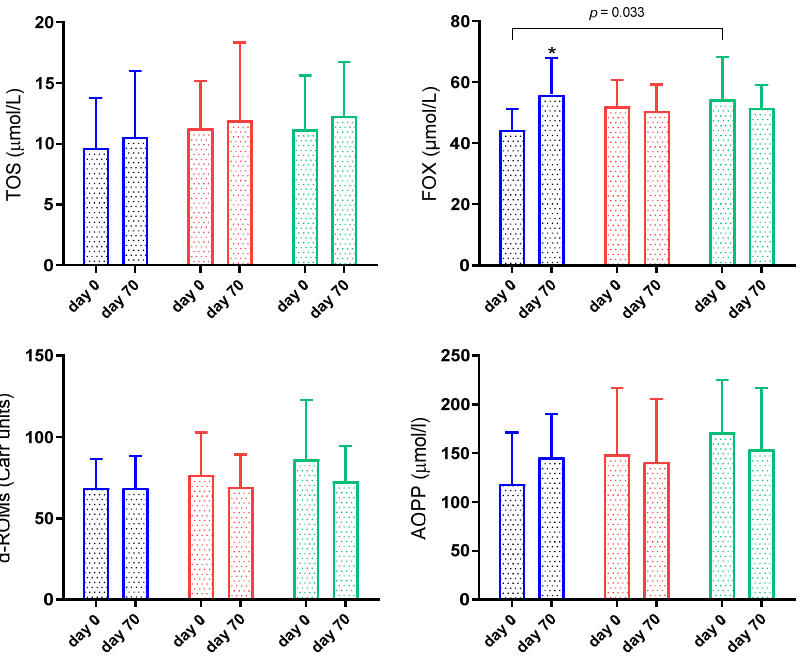
Figure 4. Results for total oxidant status (TOS), ferrous oxidation-xylenol orange (FOX), reactive oxygen metabolites derived compounds (d-ROMs), advanced oxidation protein products (AOPP) in sheep naturally infected by gastrointestinal nematodes. G1 (blue bar): faecal worm egg counts (EPG) higher than 5000 and packed cell volume (PCV) lower than 24%; G2 (red bar): EPG higher than 5000 and PCV higher than 24%; G3 (green bar): EPG lower than 5000 and PCV higher than 24%. Asterisks indicate significantly different from day 0. * p < 0.05.